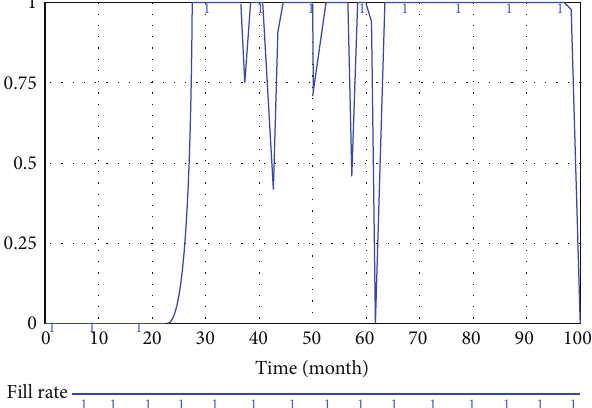
Figure 26: The service level of VMI&TPL integrated operational model under random